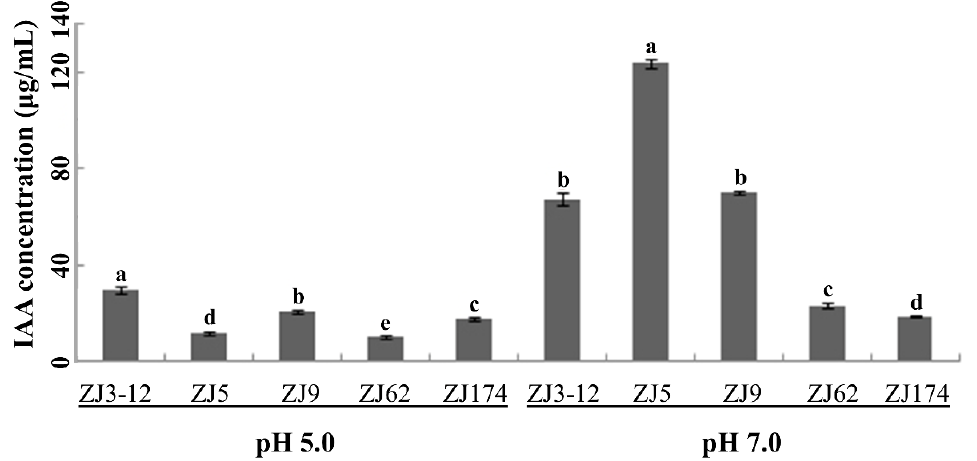
Figure 5. Effect of different pH on IAA production of five strains was determined by measuring the the amount of the produced IAA, which was expressed as µg IAA secreted per unit of optical density. The IAA concentration value was calculated based on a standard curve by measuring the optical density at a wave length of 530 nm. A standard curve was drawn using serial dilutions of IAA. Values followed by different lowercase letters within the same pH indicate significant dif ference at p <